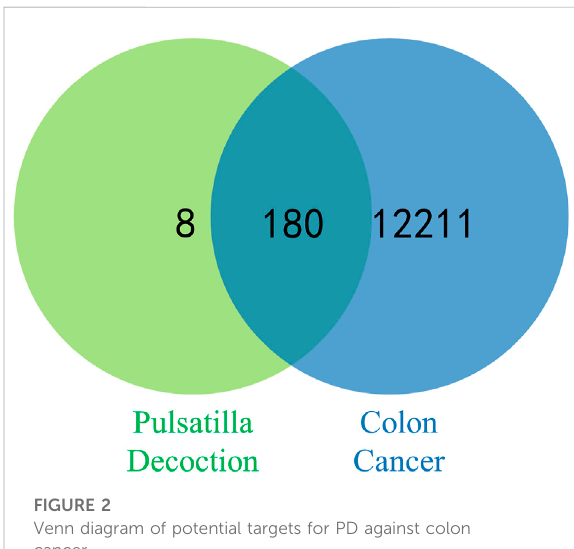
FIGURE 2 Venn diagram of potential targets for PD against colon